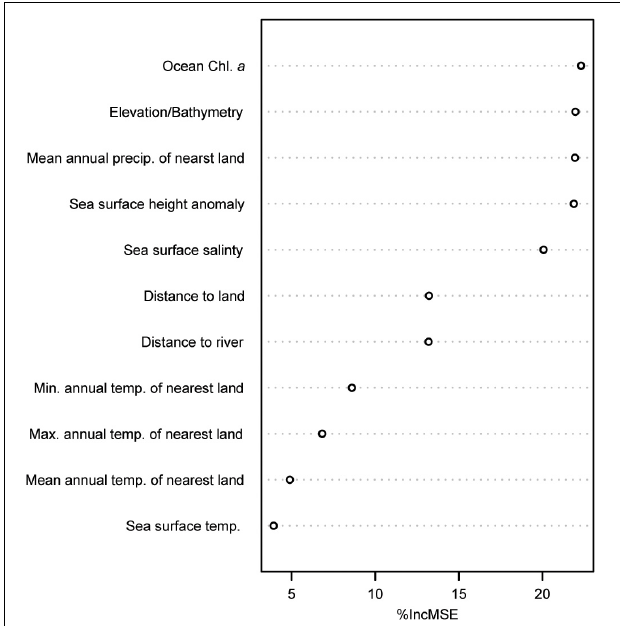
FIGURE 5 | Variable importance plot for predictor variables used in the Random Forest analysis expressed as the percent increase in mean squared error (% IncMSE). The higher the values of %IncMSE, the more important that variable is in the Random Forest model.